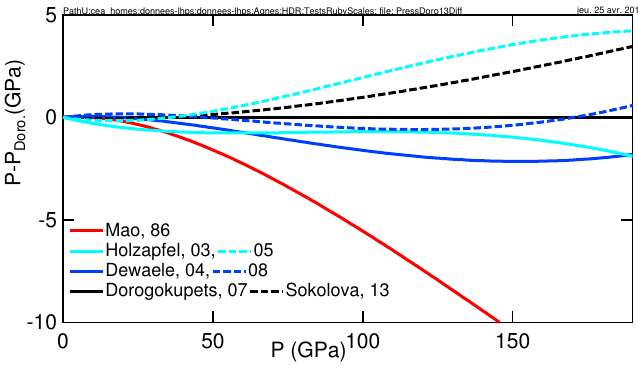
Figure 1. Comparison between calibrations of the ruby luminescence gauge [1–7]. The reference calibration is